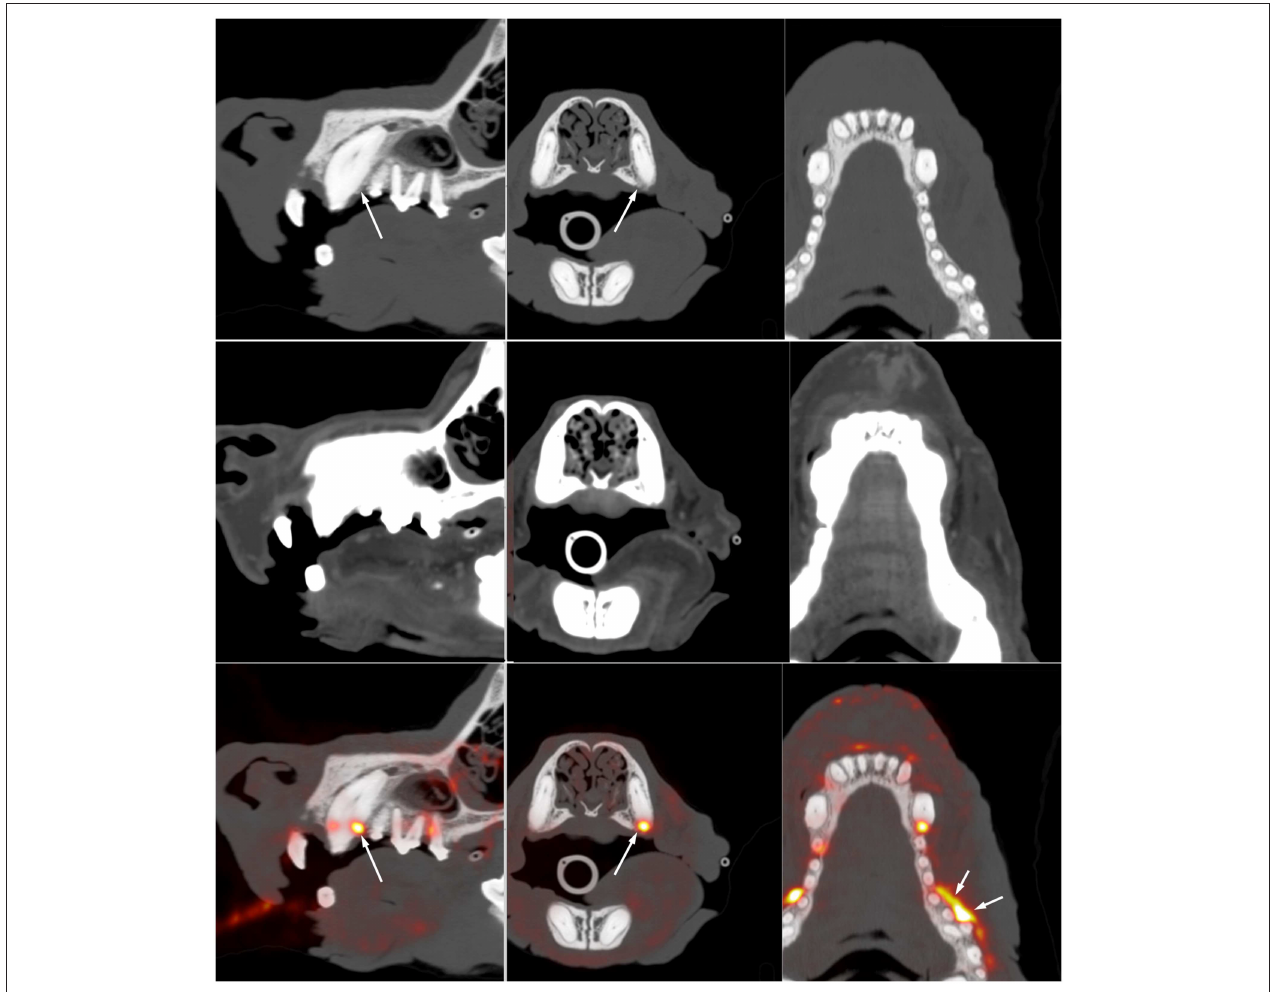
FIGURE 2 | Multiplanar reformat CT (top) and fused 18F-FDG PET (bottom) images through the maxilla of a 12-year-old Australian Cattle Dog presenting for staging of a previously resected oral melanoma. There is vertical and horizontal bone loss involving the left canine and left maxillary premolars 1, 2, and 3. Marked focal 18 F-FDG uptake (long arrow) is present at the distal aspect of the left maxillary canine. Additional resorptive areas are present adjacent to the three most mesial premolars, the lack of 18 F-FDG uptake in this area suggest that there is no active inflammation at this level. The marked 18 F-FDG uptake at the buccal aspect of premolars 3 and 4 is at the site of previous resection of an oral melanoma and likely indicate regrowth or residual tumor tissue. This case illustrates the sensitivity of 18 F-FDG PET to distinguish between active and inactive periodontal disease and to identify abnormal tissue at the site of previous tumor resection. It also demonstrates the lack of specificity and the need to interpret the images based on associated CT findings and clinical history. Note that the high spatial resolution ( ∼ 2mm) on the compact scanner (piPET, Brain Biosciences, Inc) is key in identifying these small